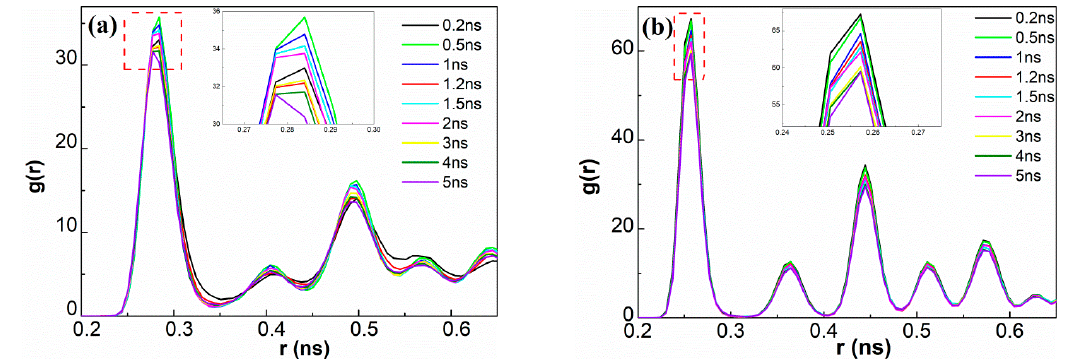
Figure 6. Variations in radial distribution functions of ( a ) Al–Al and ( b ) Cu–Cu at the weld interface during UW at different welding times. The insets show magnified views of the first peak.